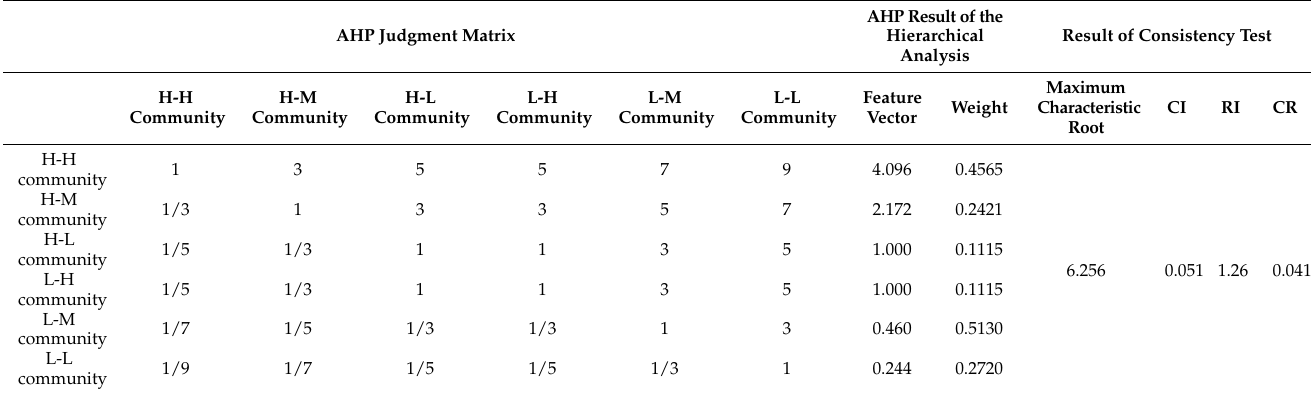
Table 1. Analytic hierarchy process judgment matrix analysis and consistency test statistic